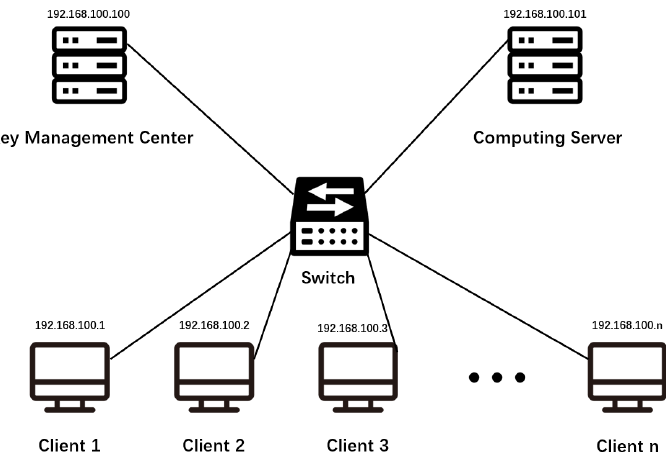
Figure 6. The network deployment in the experimental environment.